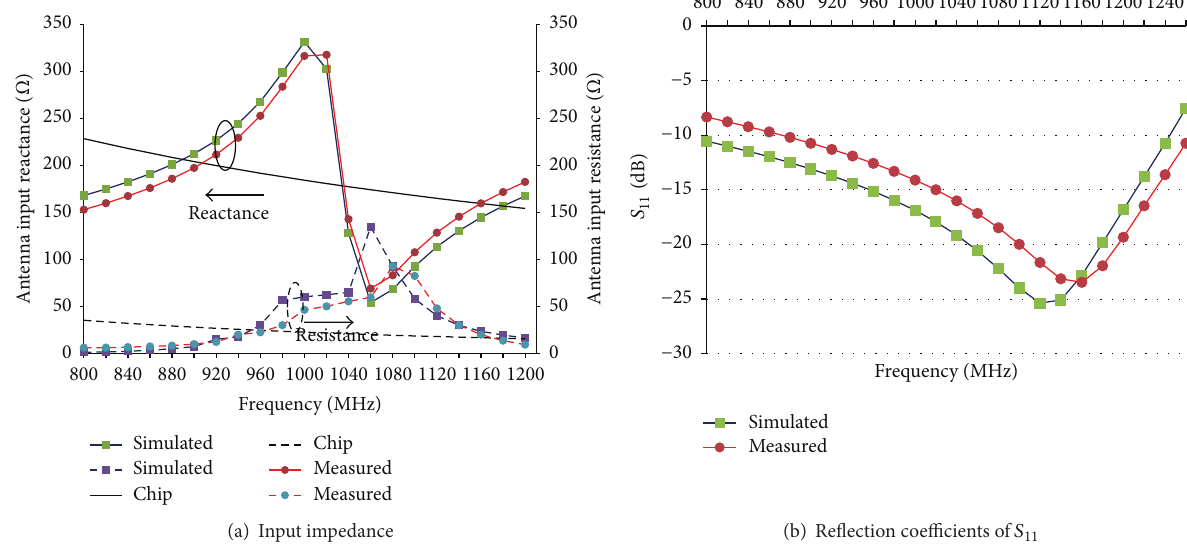
Figure 8: Impedance matching performance of the proposed